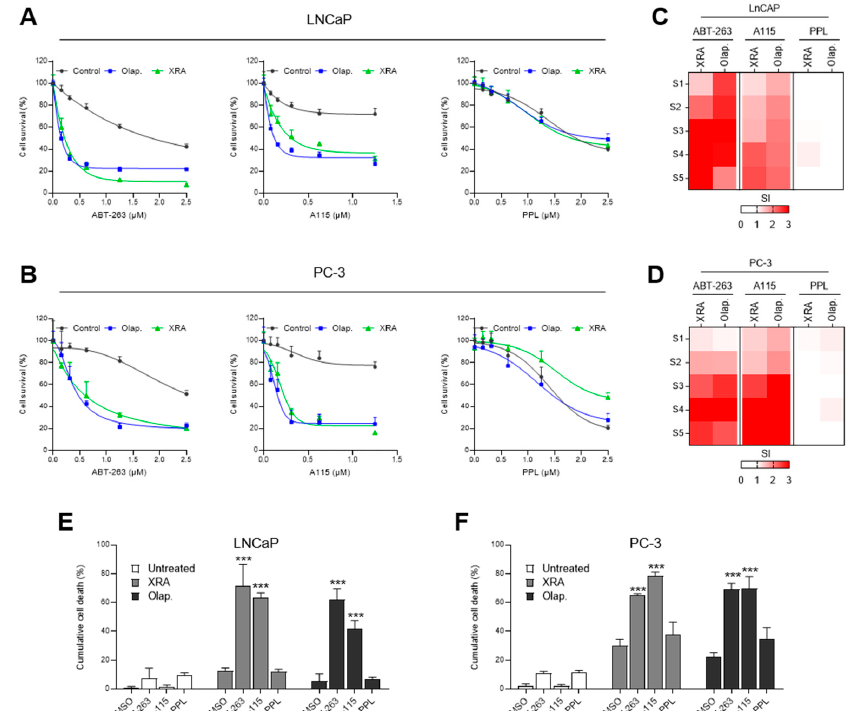
Figure 3. Bcl-2 family senolytics synergize with irradiation and olaparib. ( A – D ) LNCaP and PC-3 were infected with lentiviruses expressing H2B-GFP and treated with 8 Gy of X-Rays (XRA) or 5 µM olaparib (Olap) for 6 days, alone or in combination with increasing concentrations of ABT-263 (left), A-1155463 (A-115; middle) or PPL (right). Cell survival curves of LNCaP ( A ) or PC-3 ( B ) for the different combination treatments. Heat maps of senolytic indexes (SI) for LNCaP ( C ) or PC-3 ( D ) treated with the indicated combination treatments. S1 to S5 correspond to increasing senolytic concentrations (see Figure S3A). ( E – F ) The cumulative cell death of ( E ) LNCaP and ( F ) PC-3 were analyzed by flow cytometry 6 days after 8 Gy XRA or following 6 days’ exposure to 5 µM Olap, alone or in combination with 0.625 µM ABT-263, 0.3125 µM A-115 or 0.625 µM PPL. ( A – B ) Data are the mean ± SD of